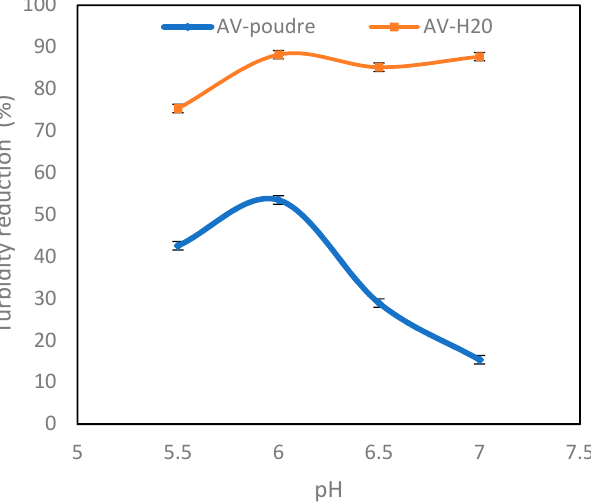
Figure 9. Effect of pH on water turbidity reduction by using AV-Powder and AV-H 2